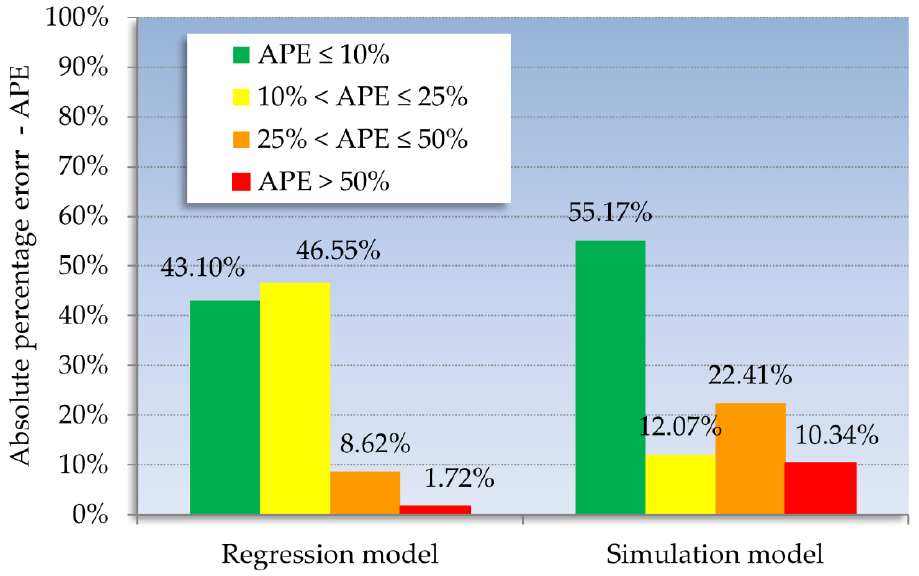
Figure 7. Absolute errors of predicted values for the regression and the simulation model.